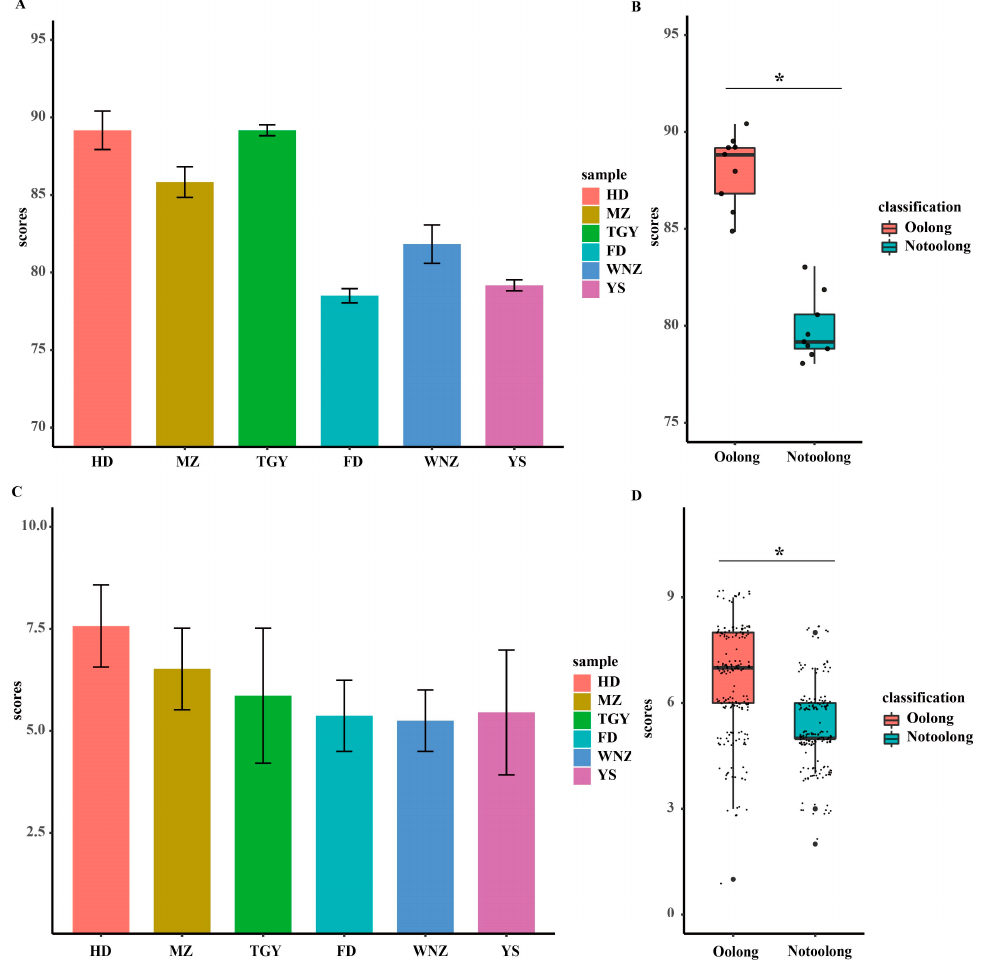
Figure 1. Sensory evaluation score plot for samples of six different tea cultivars. ( A ) Histogram of scores from expert sensory evaluation for the six different tea samples (HD, MZ, TGY, FD, WNZ, and YS). ( B ) Boxplot of expert sensory evaluation scores of oolong tea samples made from suitable cultivars (HD, MZ, TGY) and unsuitable cultivars (FD, WNZ, YS). ( C ) Histogram of consumer acceptance evaluation scores of six tea cultivars. ( D ) Boxplot of consumer acceptance evaluation scores of oolong tea made from suitable cultivars (HD, MZ, TGY) and unsuitable cultivars (FD, WNZ, YS). Oolong: oolong tea samples made from suitable cultivars (HD, MZ, TGY); Notoolong: oolong tea samples made from unsuitable cultivars (HD, MZ, TGY). “*” indicates significant difference at p < 0.01 in Student t-test. The black dots : the scores from every expert and consumer.